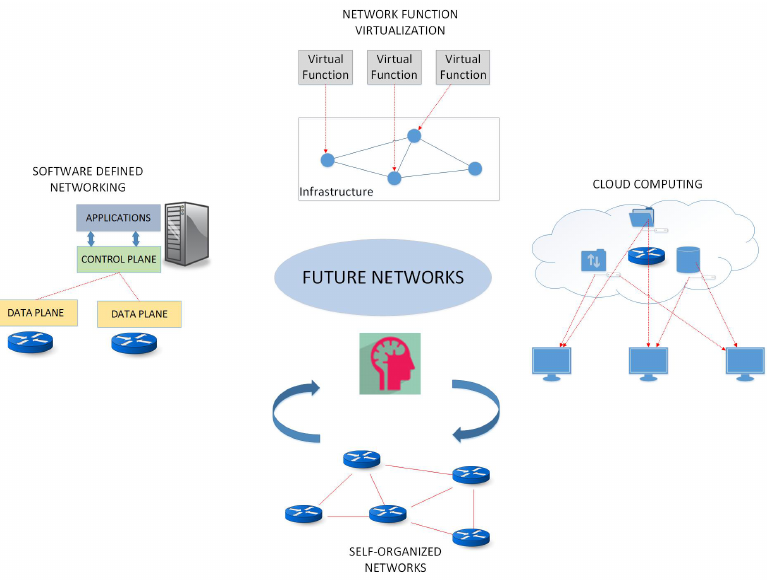
Figure 3. Trends in Future